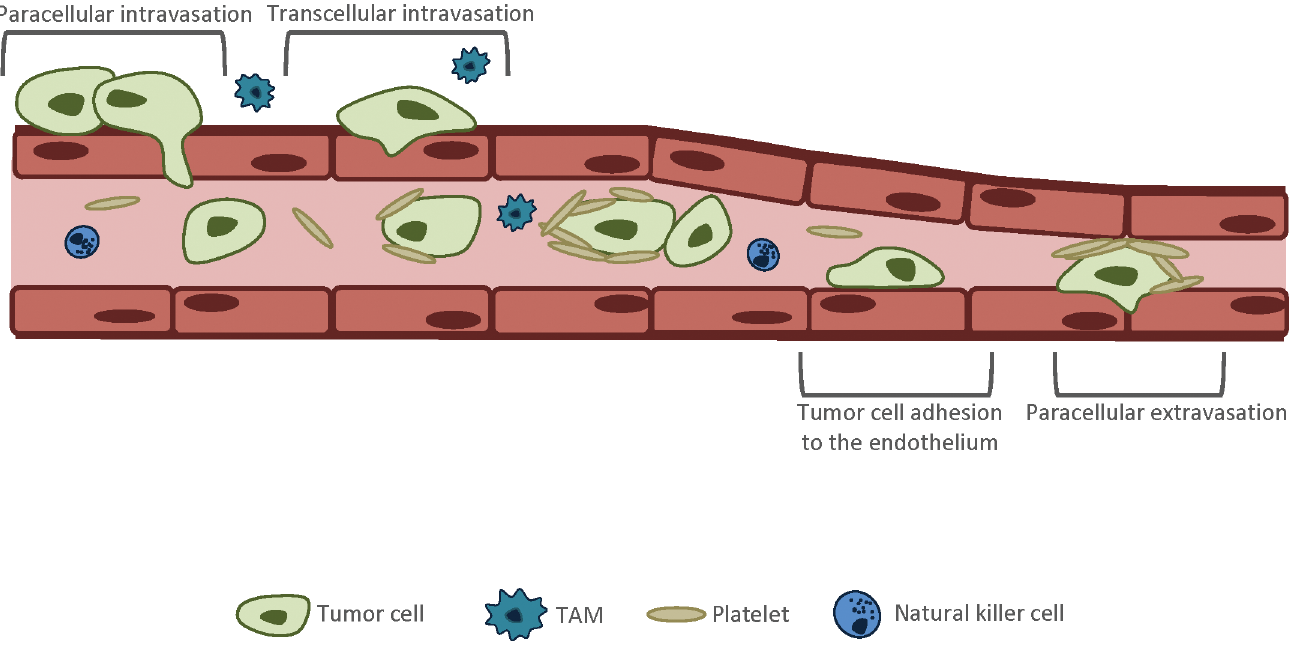
Figure 2. Crossing the endothelial barrier. There are two routes used by tumor cells to cross the endothelial cell barrier: paracellular and transcellular TEM. Paracellular TEM involves disruption of endothelial cell junctions between neighboring endothelial cells, which allows tumor cells to squeeze between them. Tumor cells induce endothelial cell junction opening by secreting a variety of factors, for exam- ple, TGF- β and VEGF. Additionally, the opening of endothelial junctions can be promoted by tumor-associated macrophages (TAMs). Transcellular TEM refers to the migration of tumor cells through the endothelial cell body, and this route of TEM seems to be used by tumor cells less often than the paracellular migratory mechanism. As tumor cells enter into the bloodstream, they encounter various challenges that dramatically decrease their chances to survive and arrive to the distant site. Aggregation with platelets provides tumor cells protection from immune cells, reduces shear stress and facilitates tumor cell adhesion and extravasation to the secondary site. Extravasation involves the specific interaction of tumor cells with vascular endothelium via cell adhesion- and chemokine-related pro- cesses. Similarly to the process of intravasation, extravasating tumor cells can cross the endothelial barrier via a para- or transcellular in the process of brain metastasis for- mation, and the ability of tumor cells to depends on the interactions between wall (32,35).